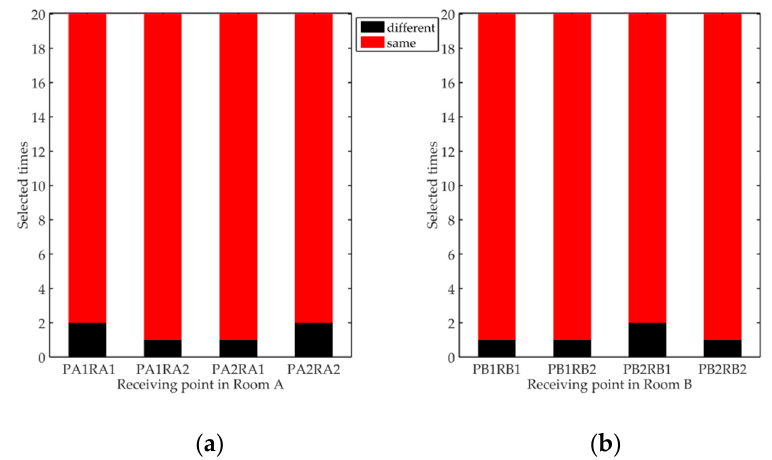
Figure 4. The distinguishability between real and simulated binaural signals. ( a ) Room A ( b ) Room